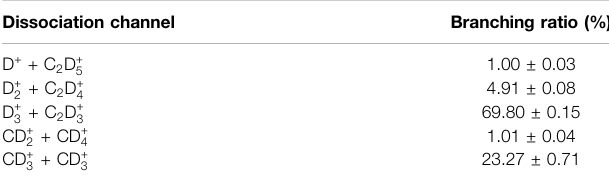
TABLE1| Ethane(C 2 D 6 )branchingratiosfortwo-bodydoubleionizationby25-fs, 1.5 × 10 14 -W/cm 2 laser pulses centered at 790-nm. Dissociation